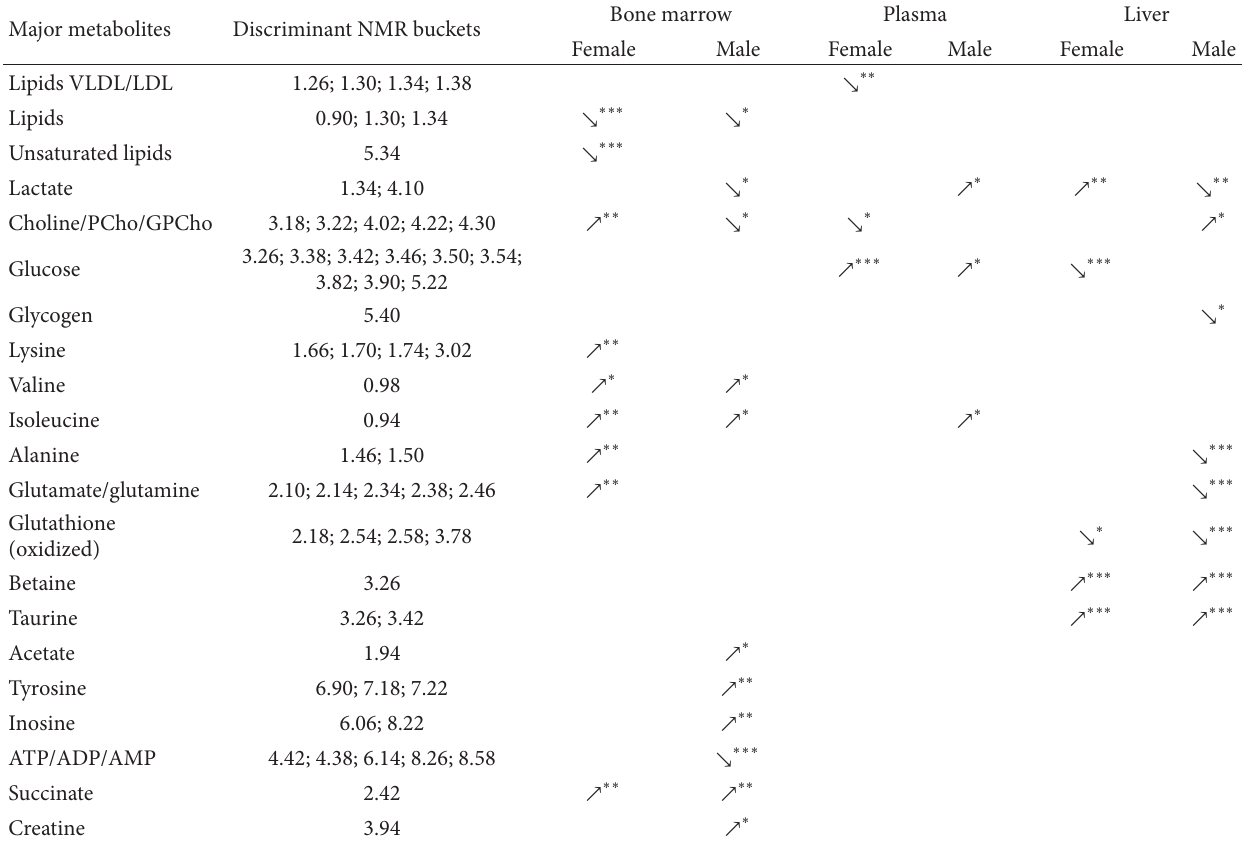
T 3: Summary of the relative metabolite changes in plasma, bone marrow, and liver upon long term dietary exposure of mice to low doses of endosulfan.